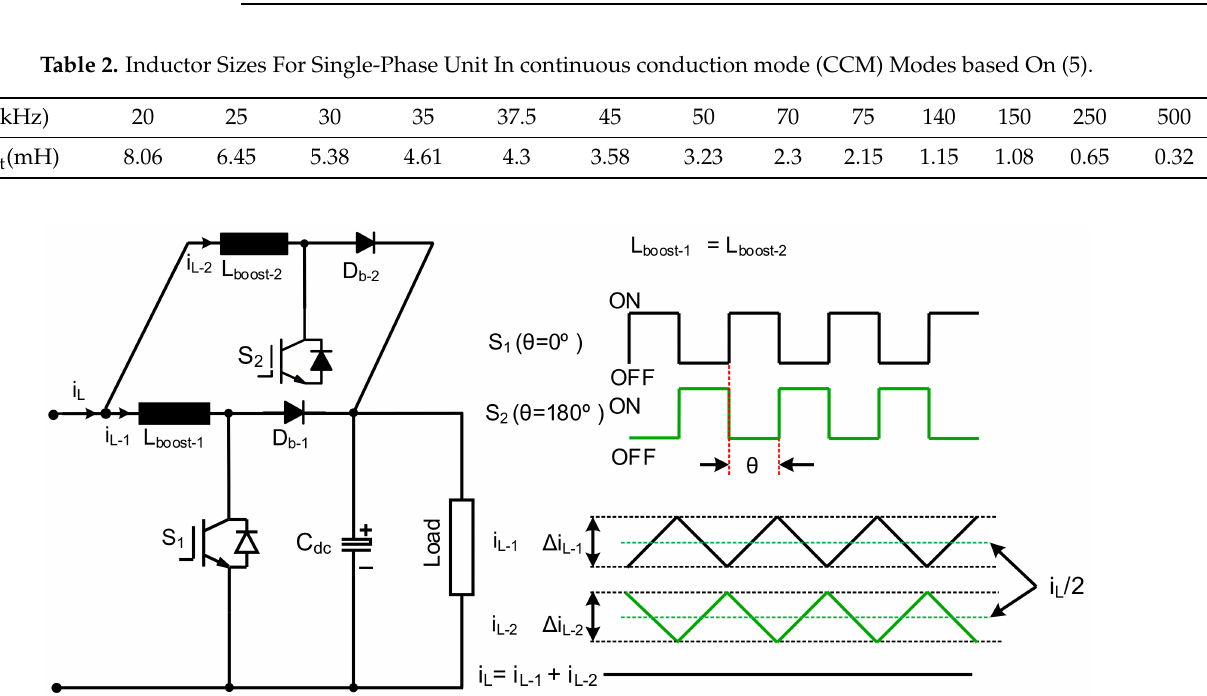
Figure 4. Analysis phase shift effects on input ripple current in two units interleaved boost stages. The phase shift between units is considered 180 ◦